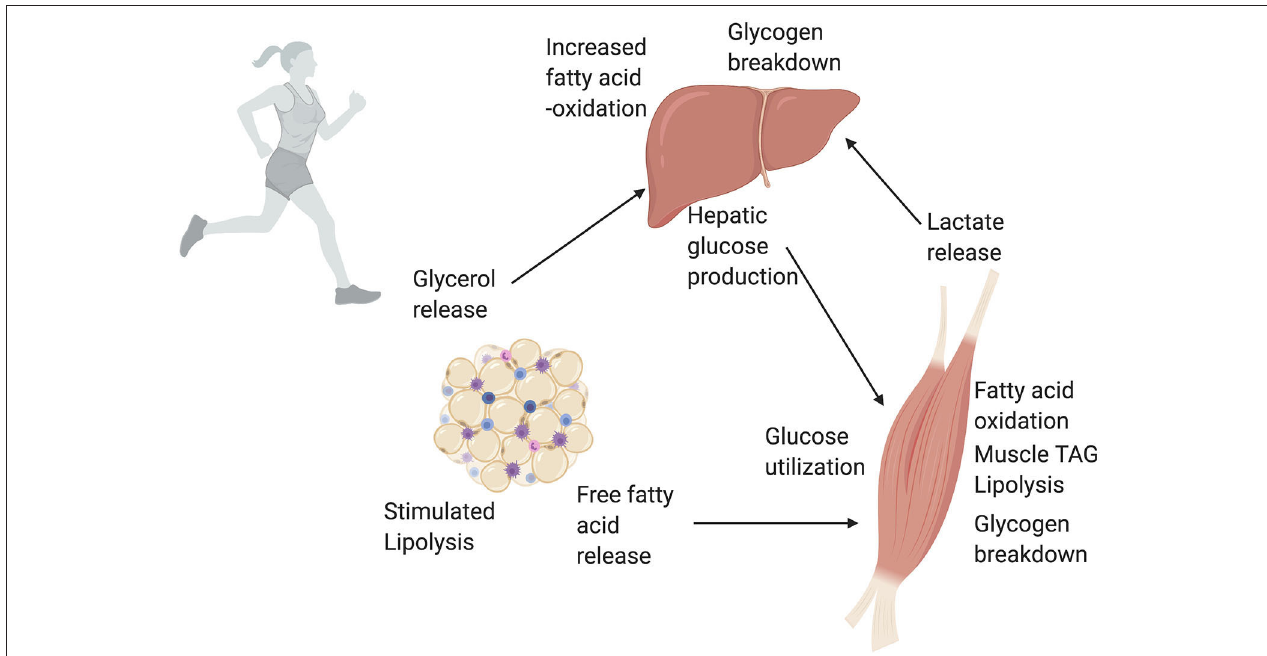
FIGURE 5 | A simplified overview of white adipose tissue (WAT), liver, and skeletal muscle cross talk during exercise. Exercise massively increases the energy demands of working skeletal muscle. To meet these energy demands, skeletal muscle uses a variety of metabolic pathways depending on exercise intensity and duration. One of the largest energy suppliers during exercise is the oxidation of lipids and glucose. The rise in glucagon and fall in insulin during exercise trigger the liver to produce glucose that is then used by skeletal muscle. The increased energy demand on the liver to produce glucose is met through increased fatty acid oxidation in the liver. Additionally, lactate released via glycolysis in skeletal muscle can be converted to glucose in the liver via the Cori Cycle. An increase in circulating catecholamines and release of hormones during exercise stimulates lipolysis, or the breakdown of TAGs, in white adipose tissue. This catabolism of TAGs releases free fatty acids into the blood stream. Skeletal muscle uses these free fatty acids from the circulation, as well as lipolysis of intramuscular TAGs, for fatty acid oxidation and energy production. Finally, the glycerol released by WAT can be used by the liver to produce glucose. Through these series of networks, WAT, liver, and skeletal muscle all work together during exercise to meet increased energy demands. This figure created with